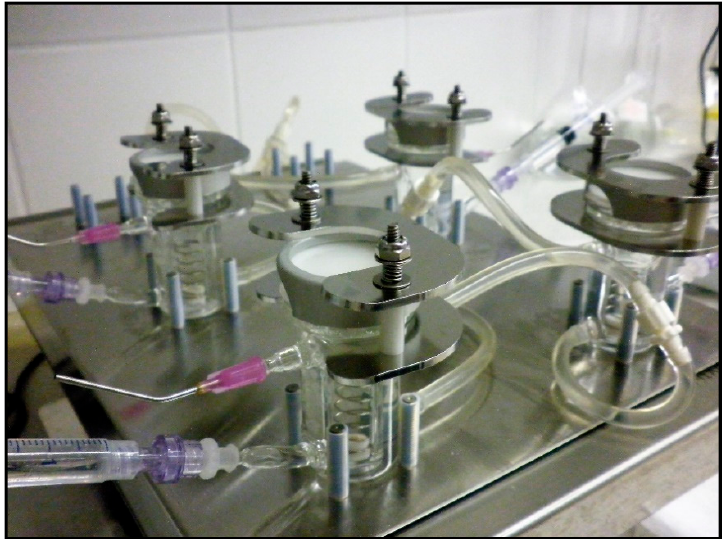
Figure 1. The vertical Franz diffusion cell system with helical magnetic stirrers in the acceptor chamber.